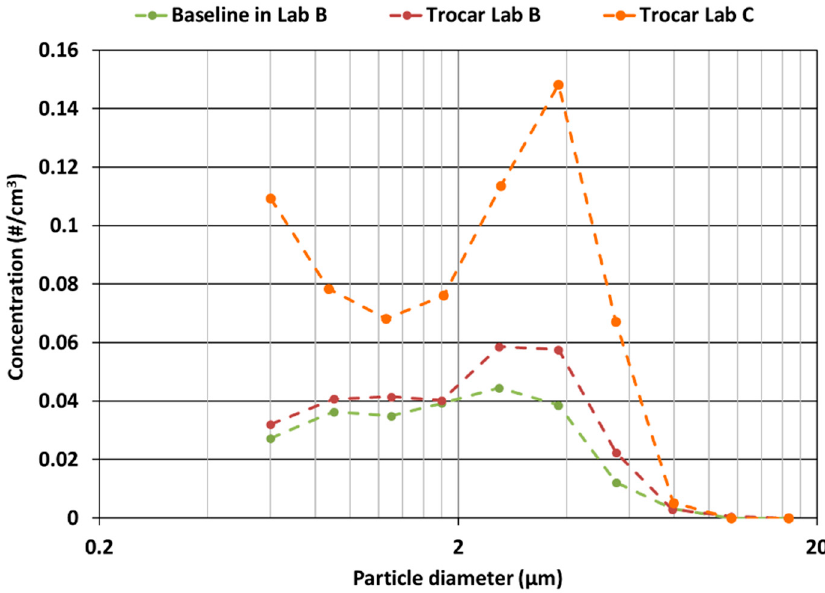
Figure 11. Comparison of the average particle size distribution of bioaerosols emitted when using the trocar, for labs B and C. (#/cm 3 : number of particles per cm 3 of